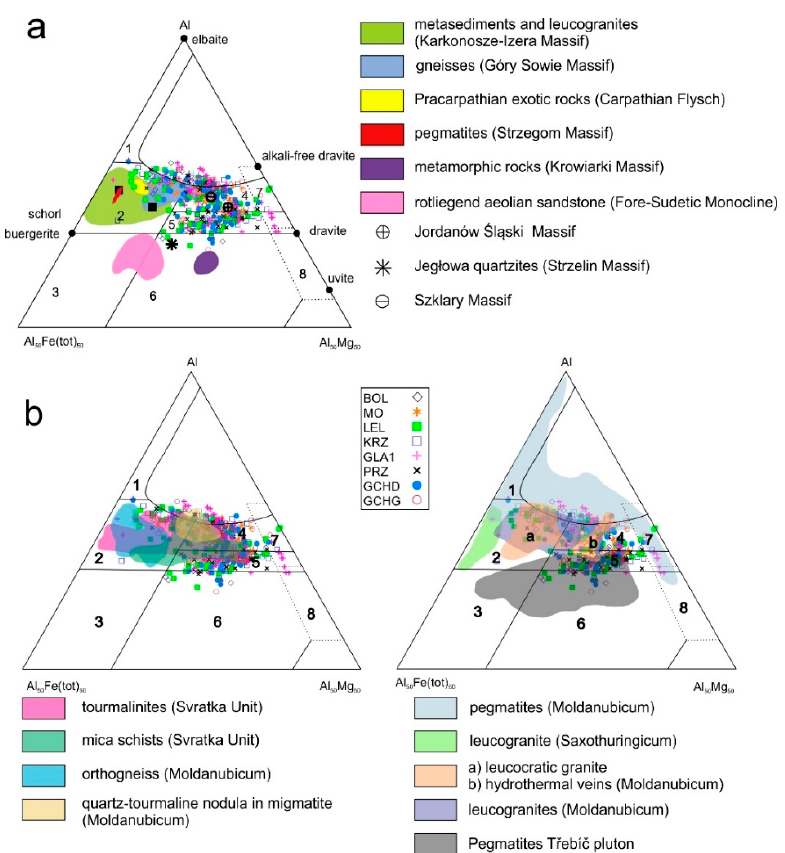
Figure 10. Comparison of detrital tourmalines from the study area plotted in Fe–Al–Mg ternary diagrams of Henry and Guidotti [69]. Coloured fields reflect the chemical composition of tourmalines from ( a ) different rock types and localities of Poland [35]; ( b ) different rock types and localities of Bohemian Massif [17,18,22,55,58,126–130]. Explanation for fields (1–8) the same as in Figure 8.